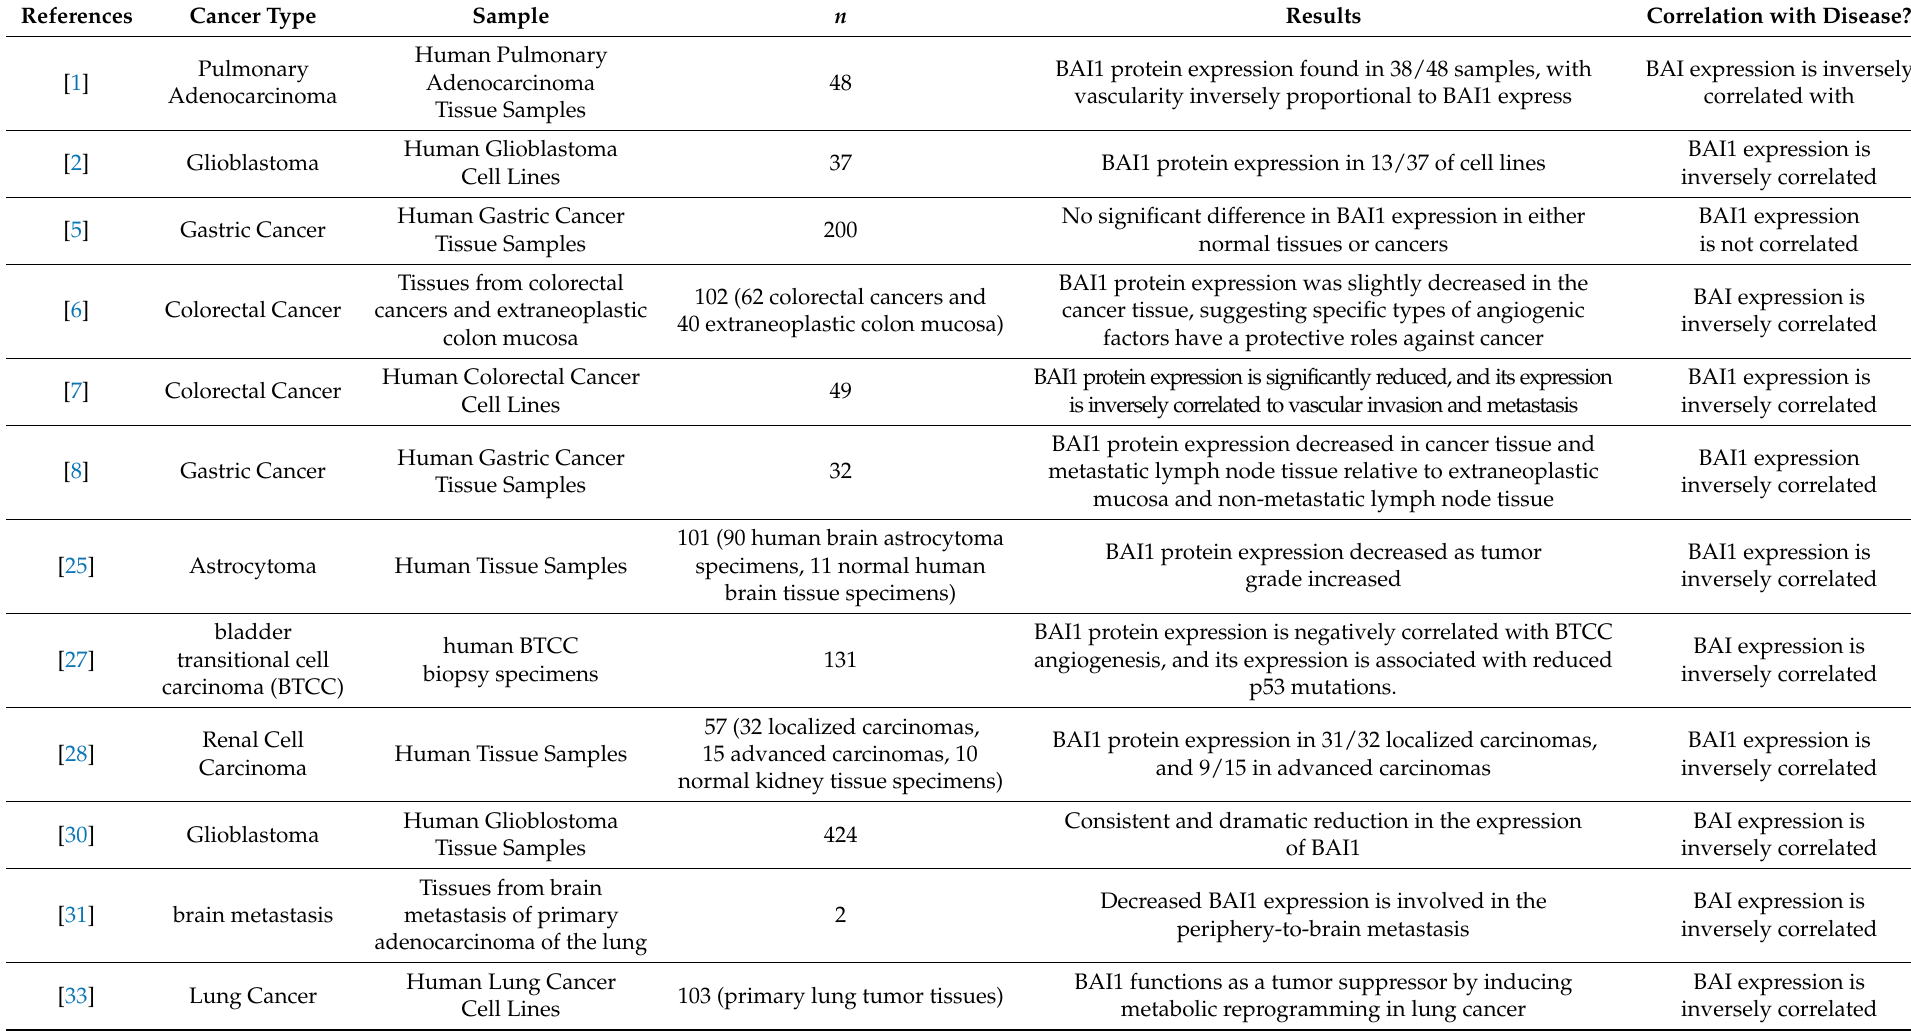
Table 1. The list of references shows that BAI1 expression is inversely correlated with the tumor malignancy and survival prognosis in